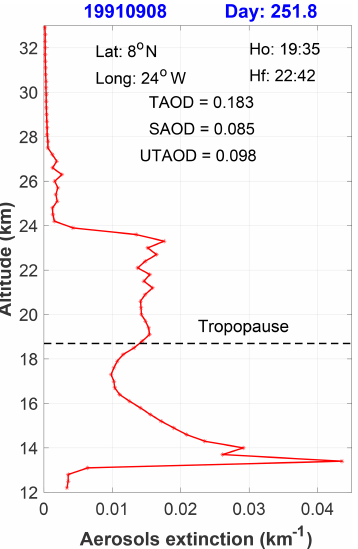
Figure 3. Profiles of the α aer ( z ) for 8 September at 8 ◦ N, showing the presence of cirrus clouds between 13 and 14km. In addition, between 20 and 18km the transport of stratospheric aerosols from the stratosphere into troposphere across the tropopause is evident.